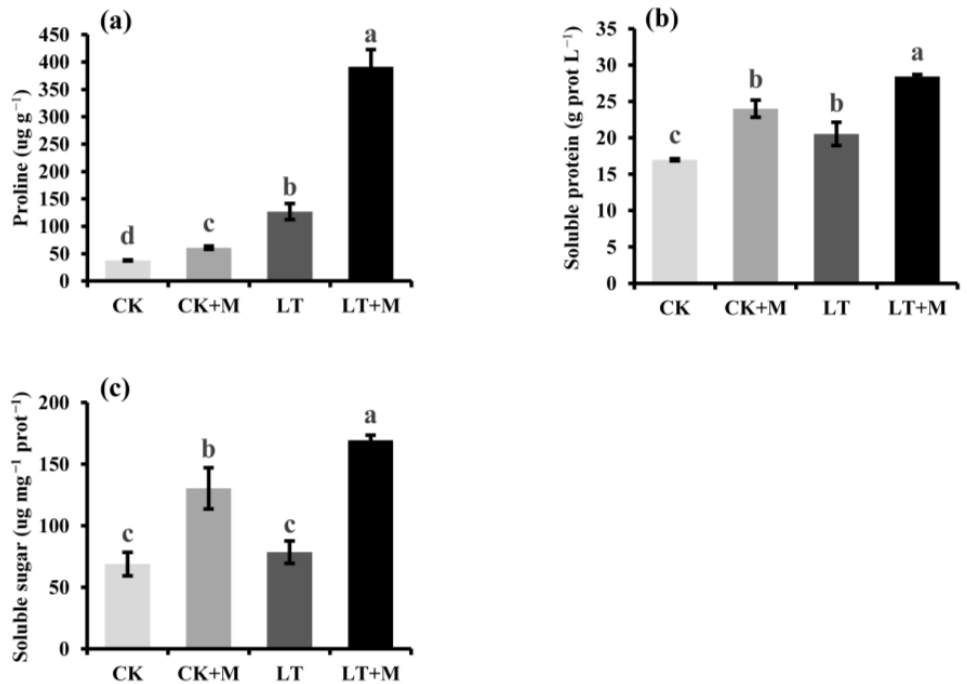
Figure 3. Effects of wood vinegar on osmotic adjustment substances in rapeseed seedlings proline ( a ), soluble protein ( b ), and soluble sugar ( c ) under low-temperature stress. Error bars are ± SE ( n = 3). According to the LSD test, the lowercase letters in the figure indicate significant differences ( p < 0.05). CK, normal temperature; CK + M, normal temperature + wood vinegar; LT, low tempera- ture; LT + M, low temperature + wood